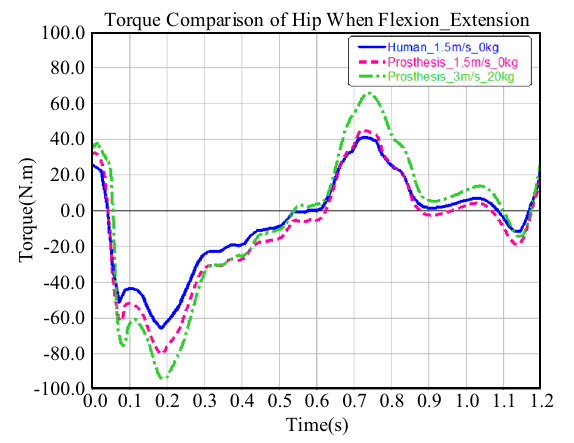
Figure 21 Changes in hip torque in multiple gait